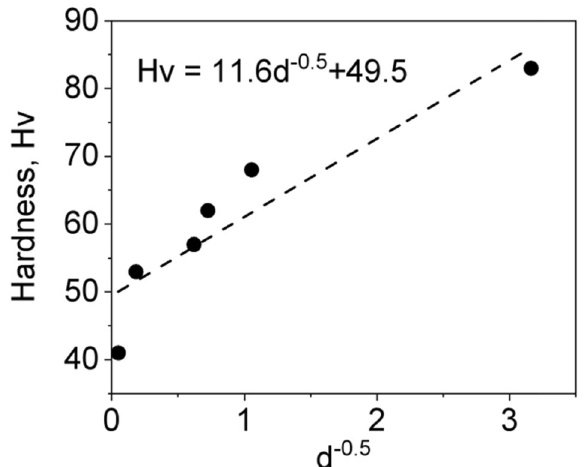
Fig. 10 Hall-Petch pro fi le. Hall – Petch relation of GG Al – Mn alloy showing the hardness as a fucntion of d − 0.5